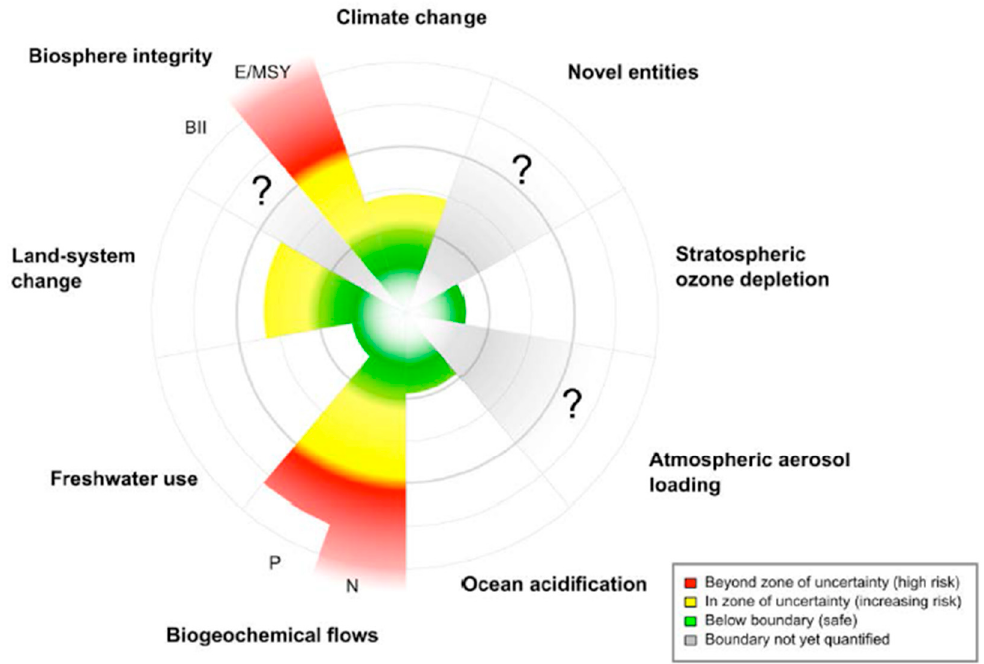
Figure 1. Crossing planetary boundaries, from Steffen, Richardson, Rockström et al. Reprinted with permission from AAAS.